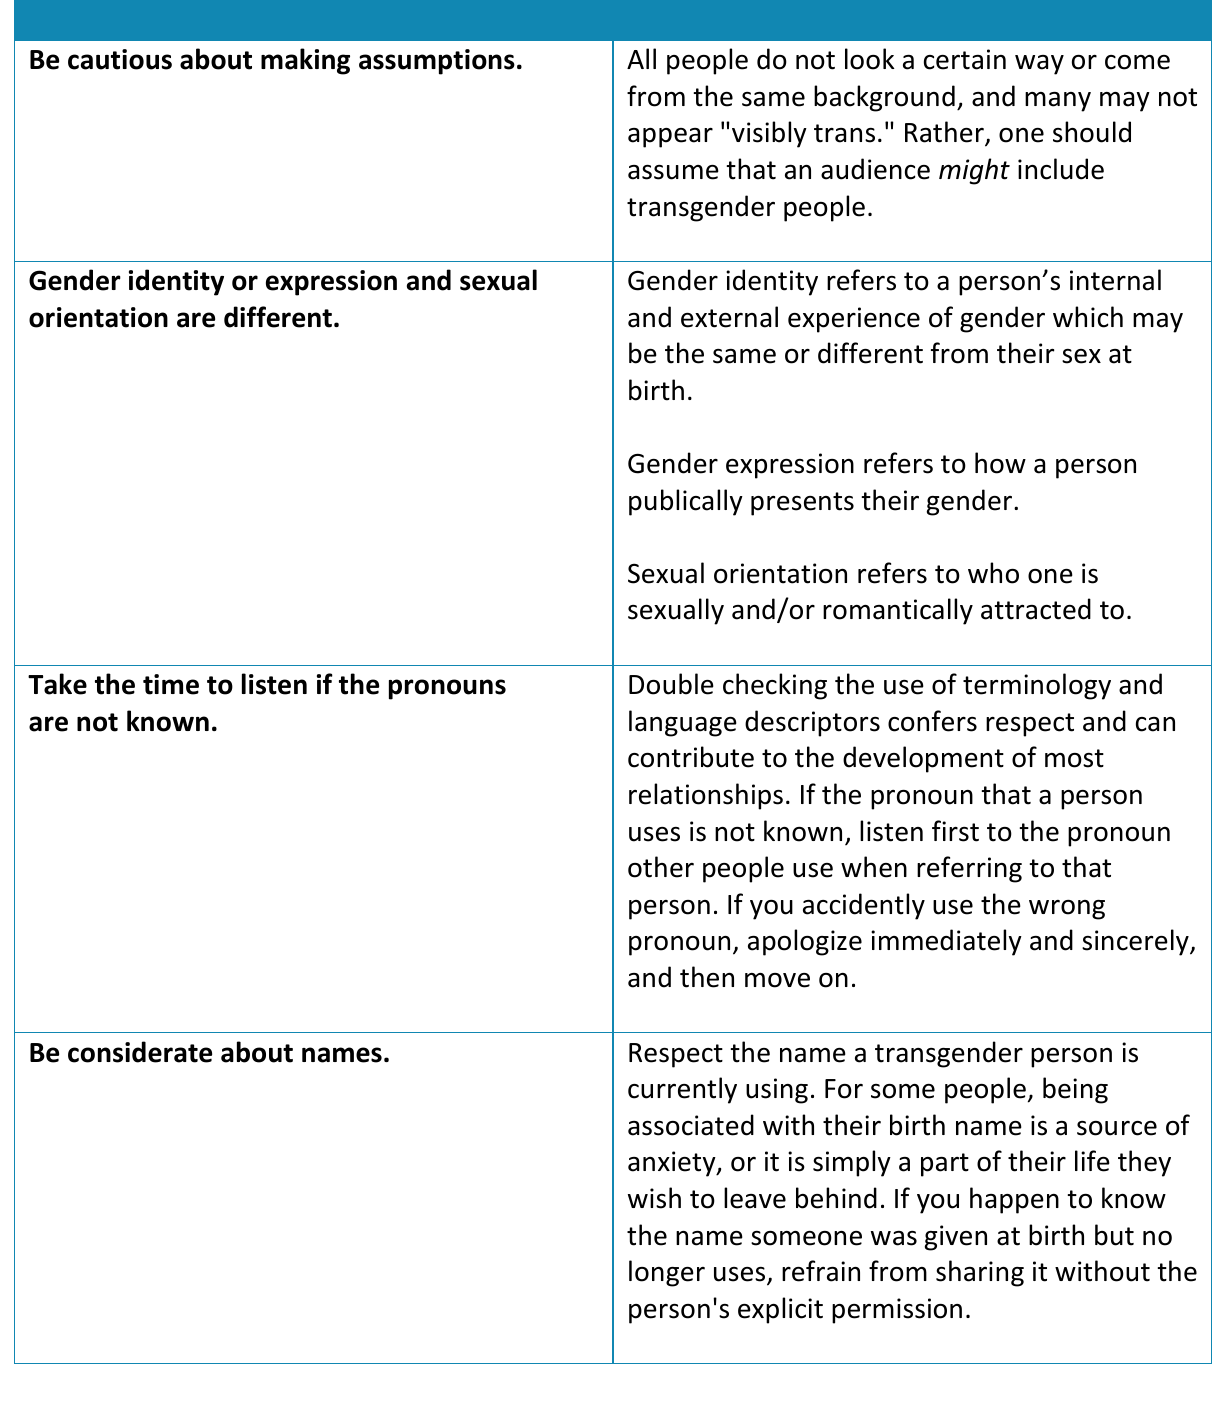
Page | 22 | Words Matter: Guidelines on Using Inclusive Language in the